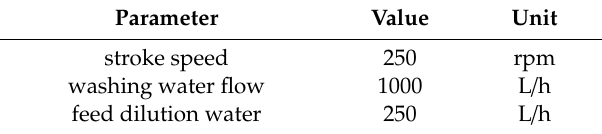
Table 2. Conditions for wet shaking table (WST) separation of HC FeCr slag (fraction 1–2 mm). Parameter Value Unit